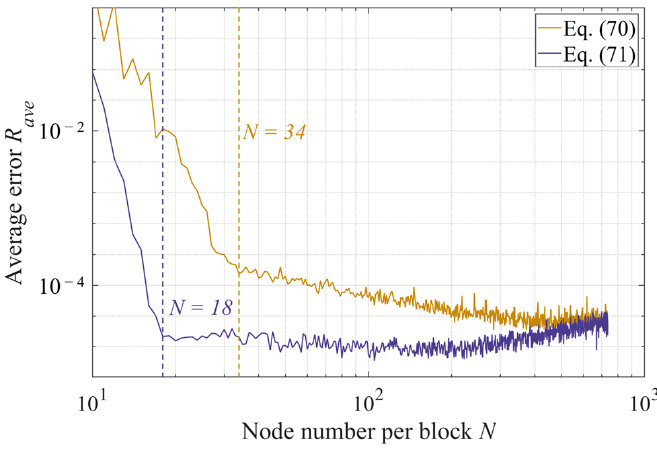
Figure 4. Comparison between DQM and analytical solutions: ( a ) Equation (70) and ( b ) Equation (71). N = 51.